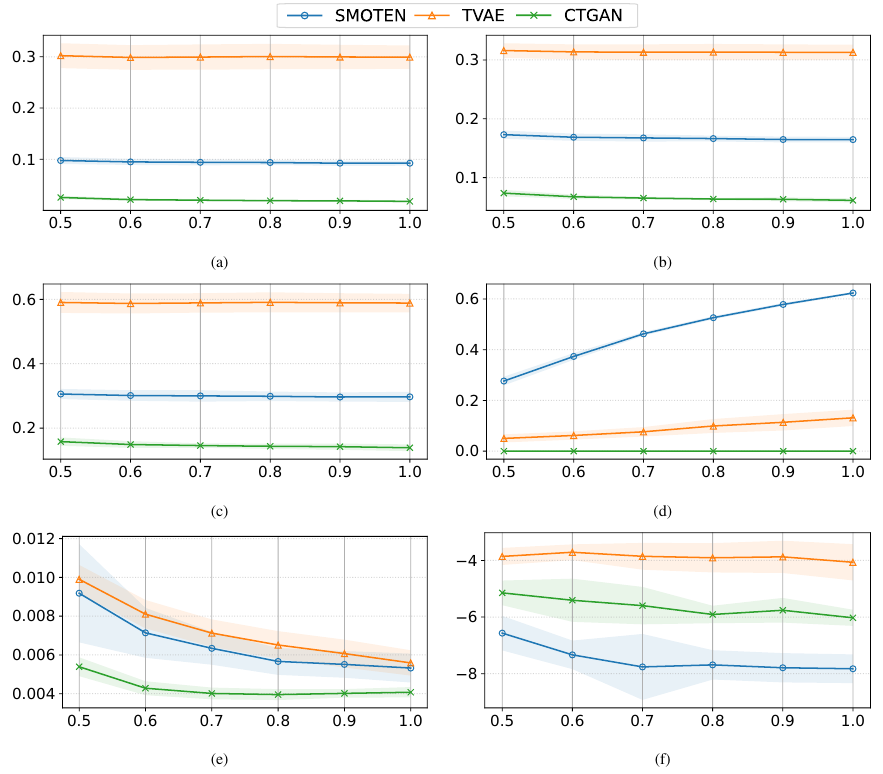
Figure 4. Mean ± std for the synthetic data quality metrics when considering a range of IR values (from 0.5 to 1) and different oversampling techniques (SMOTEN, TVAE and CTGAN). ( a ) KLD; ( b ) HD; ( c ) MAEP; ( d ) RSVR; ( e ) PCD; ( f )